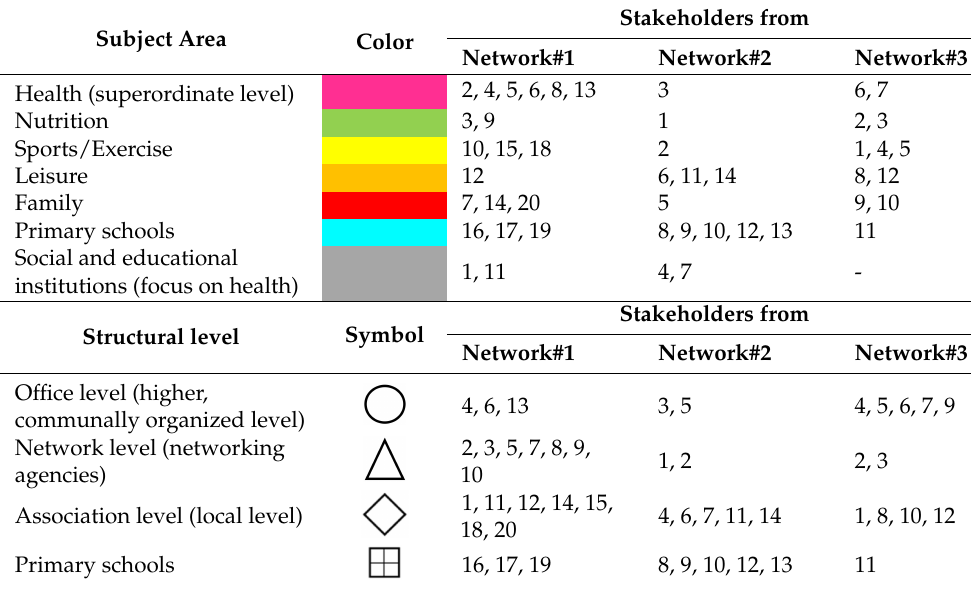
Table 1. Subject area and structural level of the networks.